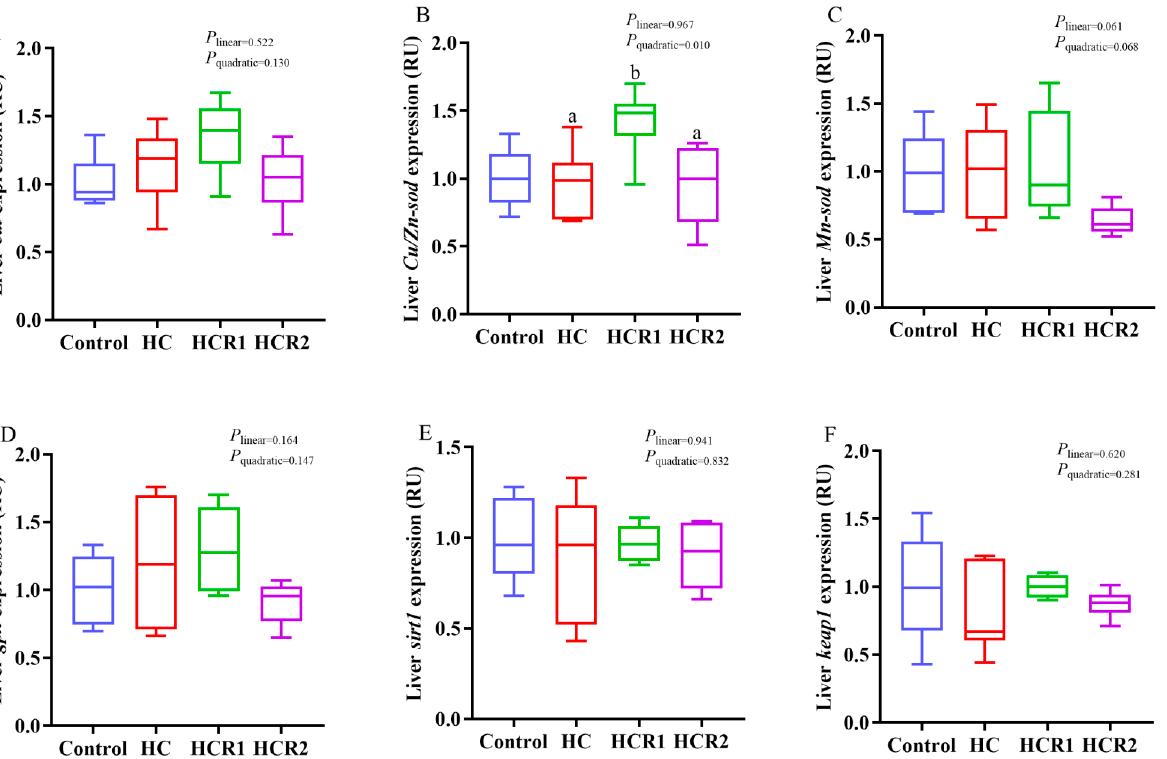
Figure 4. Hepatic transcriptions of the genes involved in the antioxidant defense. The mRNA levels of catalase ( cat ) ( A ), copper/zinc superoxide dismutase ( Cu/Zn-sod ) ( B ), manganese superoxide dismutase ( Mn-sod ) ( C ), glutathione peroxidase ( gpx ) ( D ), sirtuin 1 ( sirt1 ) ( E ), kelch-like ECH associating protein 1 ( keap1 ) ( F ) were evaluated using real-time RT-PCR. Data are referred to the values (relative units, RU) obtained in fish fed the control diet. Each data point represents the mean of four replicates (4 individuals per replicate). ab Compared among the HC, HCR1, and HCR2 groups. Bars assigned with different superscripts are significantly different ( p < 0.05). The first and third quartiles are represented by the top and bottom of the box, while the minimum and maximum values are represented by the whiskers. Control, diet with 32% nitrogen-free extract; HC, diet with 45% nitrogen-free extract; HCR1, diet with 45% nitrogen-free extract and 0.04% resveratrol; HCR2, diet with 45% nitrogen-free extract and 0.08% resveratrol.